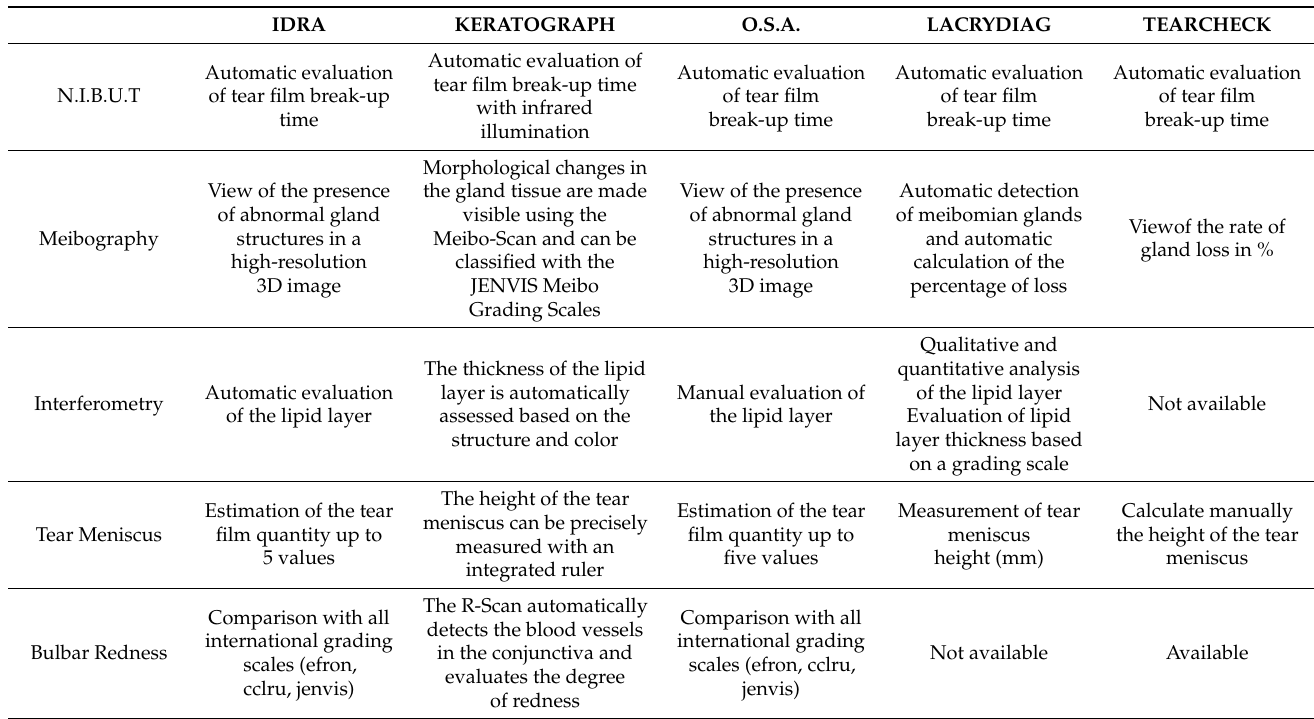
Table 1. Multi-imaging-integrated devices and